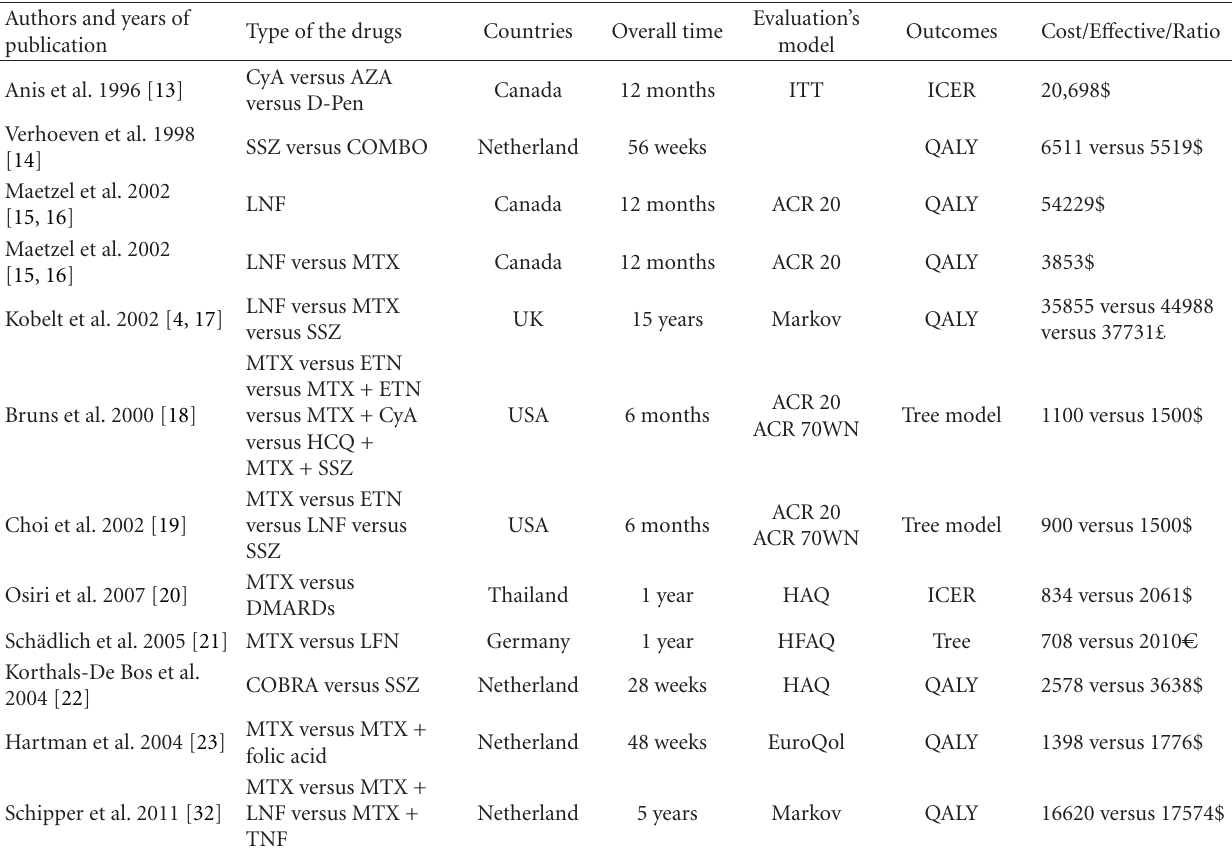
Table 1: Studies on cost e ff ectiveness analysis of DMARDs in rheumatoid